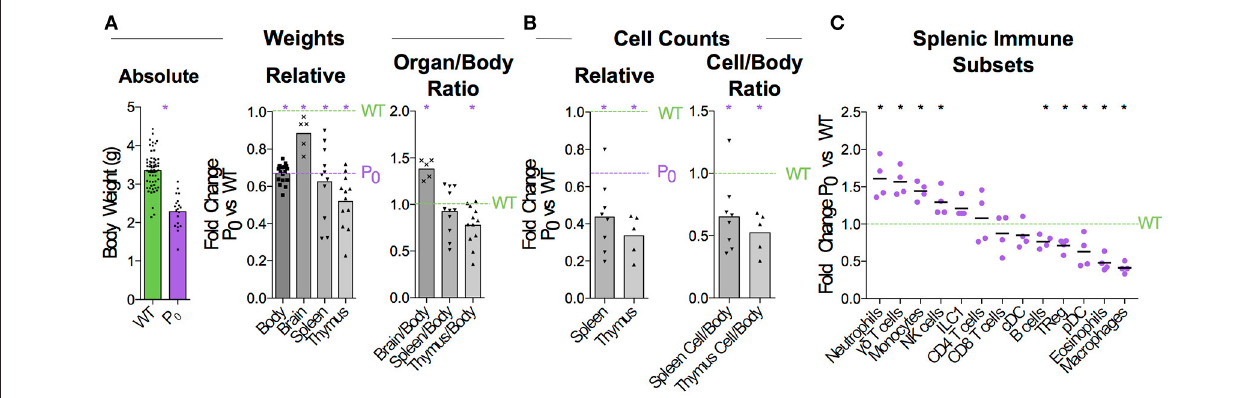
FIGURE 1 | FGR leads to Brain-Sparing at the Expense of Thymus. WT dams were mated with P 0 males to produce P 0 and WT offspring. The number of WT and P 0 animals or organs analyzed for each measurement is given in parentheses. (A) Neonates were analyzed 5 days after birth for absolute body weight ( n = 61, 19). Relative body and organ weights from P 0 neonates were compared with littermate controls. Purple dashed line was defined by the average P 0 body weight, to allow relative comparison of organ weights to both P 0 and WT. (Relative Body Weight n = 41, 18; Brain n = 7, 5; Spleen n = 32, 11; Thymus n = 28, 12). Organ/Body ratios were compared between P 0 and WT littermates. (B) Absolute cell counts within the spleen and thymus were compared with littermate controls (Spleen Cells n = 16, 8; Thymus Cells n = 7, 5). Cell counts as a ratio to mouse weights were compared with littermate controls. (C) Spleen cells were analyzed using flow cytometry and the proportions of the indicated immune cell populations were compared with littermate controls (Spleen Flow Cytometry n = 10, 5, with 1 outlier removed using the ROUT method). Datasets were tested for normality using the Shapiro-Wilk normality test. Normally distributed data were compared using unpaired two-tailed t -tests while non-parametric data were compared using Mann-Whitney Rank comparison tests. For all tests, * P <